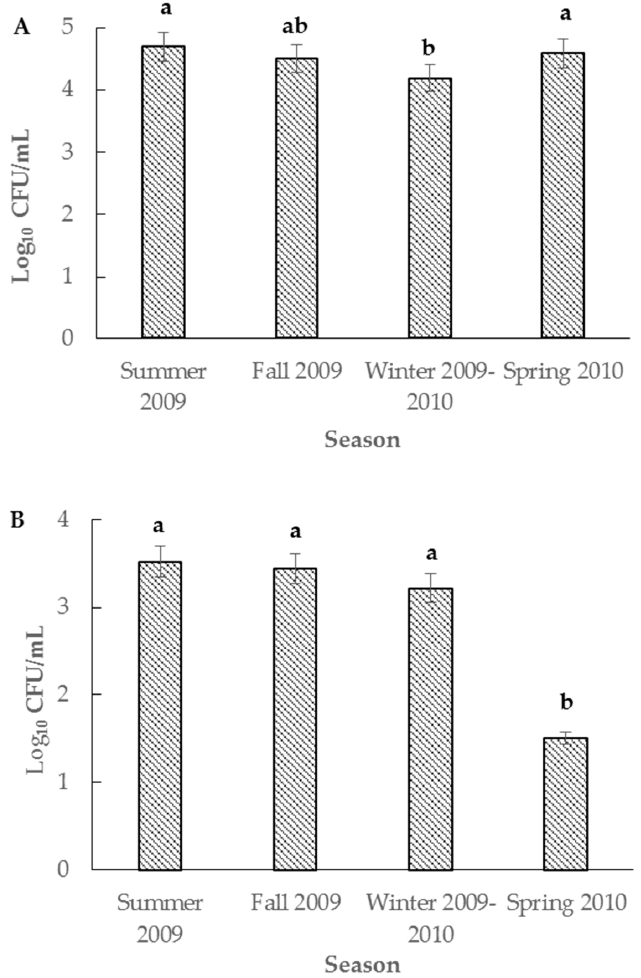
Figure 1. Total coliforms ( A ) and presumptive E. coli ( B ) population in nopal juices collected during June 2009 and May 2010. In total, 162 samples were analyzed: summer, 42 samples; fall, 45 samples; winter, 45 samples; and spring, 30 samples. Means with the same letter are not statistically different.